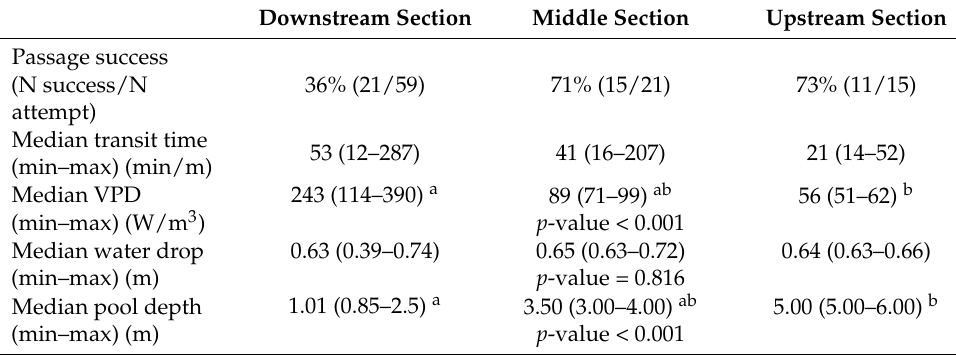
Table 4. Passage success and transit time per meter of height ascended (min/m) by fishway section (see Figure 2). The median values and ranges of the volumetric power dissipation (VPD), water drop between pools, and pool depth are provided, with the p -value of comparison among sections and superscript letters indicating the pairwise test comparison (if p -value < 0.05).